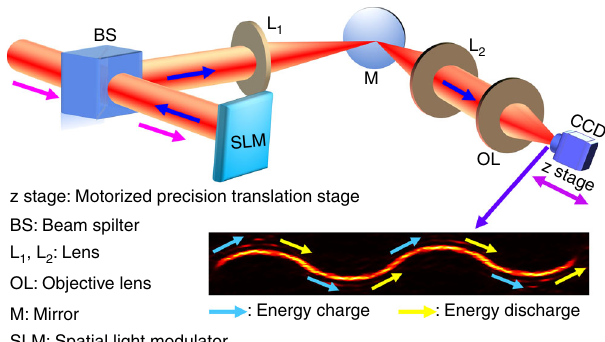
Fig. 1 Schematic of the experimental setup. A collimated incident x linearly polarized Gaussian beam with a wavelength of λ = 632.8 nm propagating along the optical axis passes through a phase-only SLM (spatial light modulator), two lenses (L 1 , L 2 ) before it is focused by the objective lens (OL) (NA = 0.095). The magenta and blue arrows indicate the propagation directions of incident and modulated beams, respectively. BS and M are beam splitter and mirror. L 1 ( f 1 = 120 mm) and L 2 ( f 2 = 150 mm) compose a 4 f -system that conjugates the phase coded in the SLM and the entrance plane of the OL. UAD light beams with different numbers of energy oscillations can be reconstructed by recording the light intensity in different z planes using a CCD, which can be moved along the optical axis by a motorized precision translation stage ( z stage). For example, a UAD light beam with four energy oscillations propagates in an energy charge – discharge – recharge – discharge manner, with the light blue and yellow arrows denoting energy charge and discharge, respectively. One pair of adjacent light blue and yellow arrows denotes an entire energy